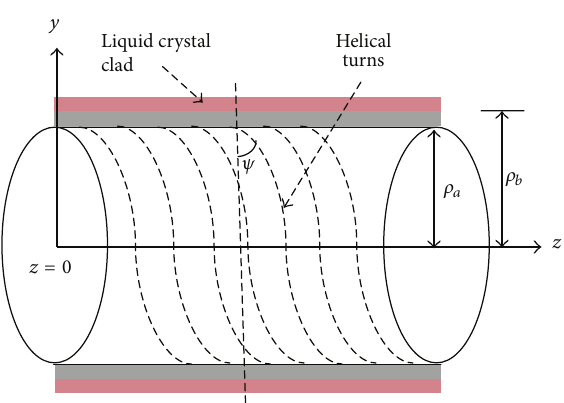
Figure 2: Longitudinal view of the HCLCOF under